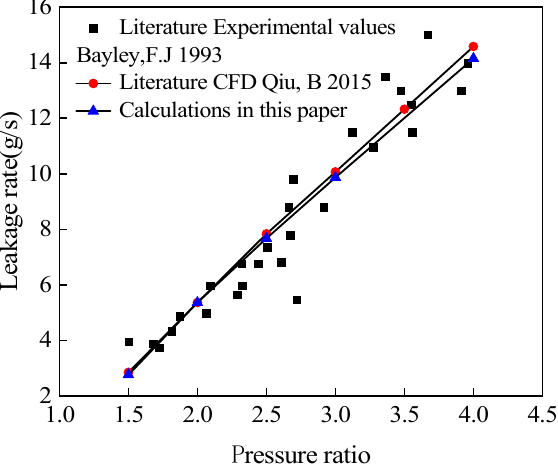
Figure 6. Leakage rate of brush seal numerical calculation comparison [14,24].